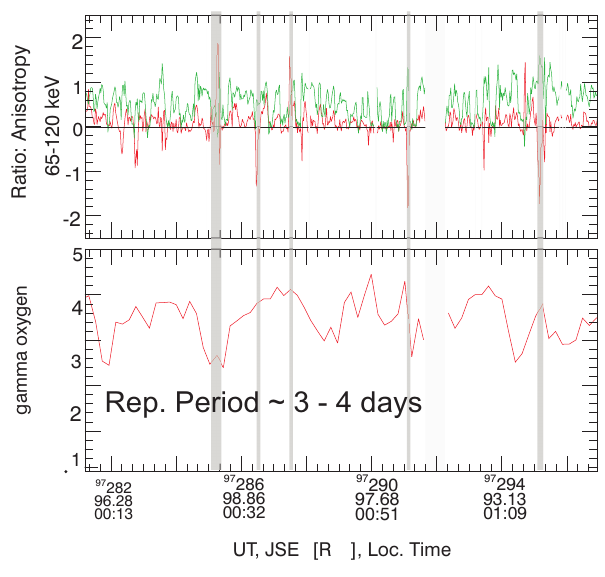
Fig. 5. Format as in Fig. 2. The time interval DOY 281, 00:00UT to DOY 297, 00:00UT in 1997 (orbit C10) is